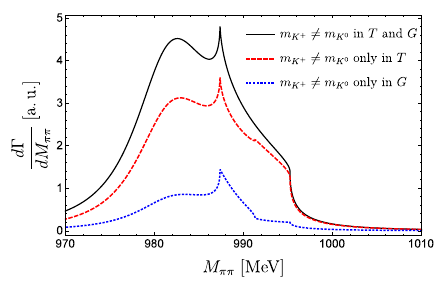
Figure 5. Invariant mass distribution of π + π − in the χ explanations).